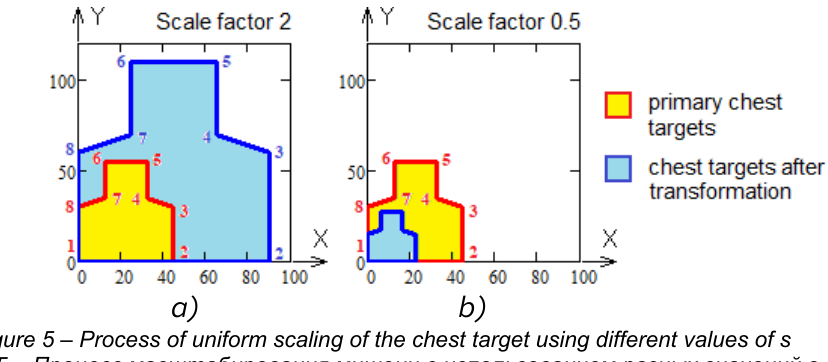
Figure 5 – Process of uniform scaling of the chest target using different values of s Рис . 5 – Процесс масштабирования мишени с использованием разных значений s Слика 5 – Поступак униформног скалирања грудне мете коришћењем различитих вредности